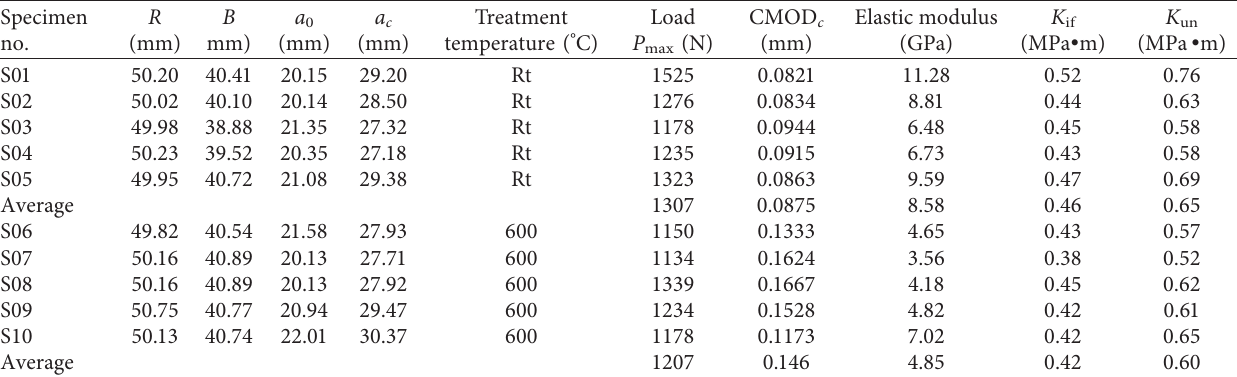
Table 3: The geometrical dimensions and fracture toughness of the